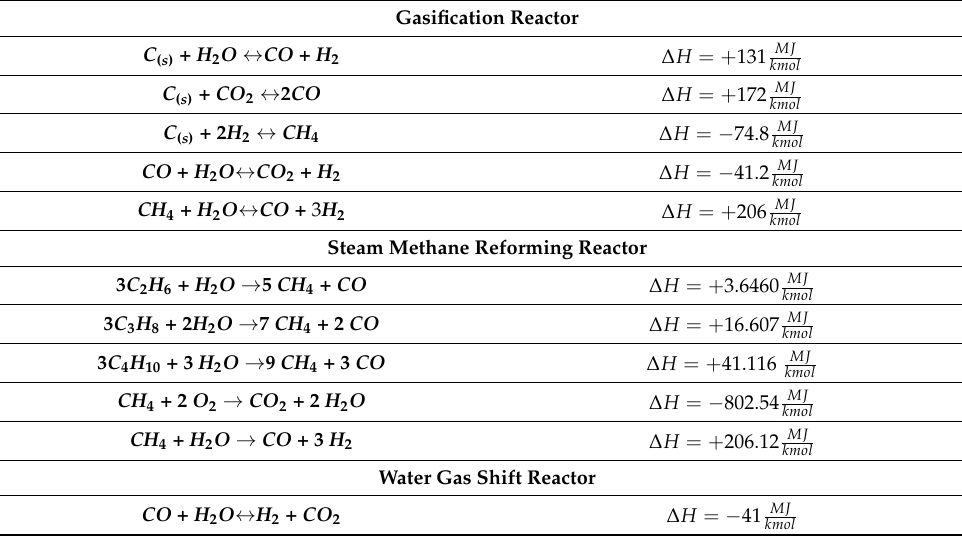
Table A1. Chemical reactions comprehended in the